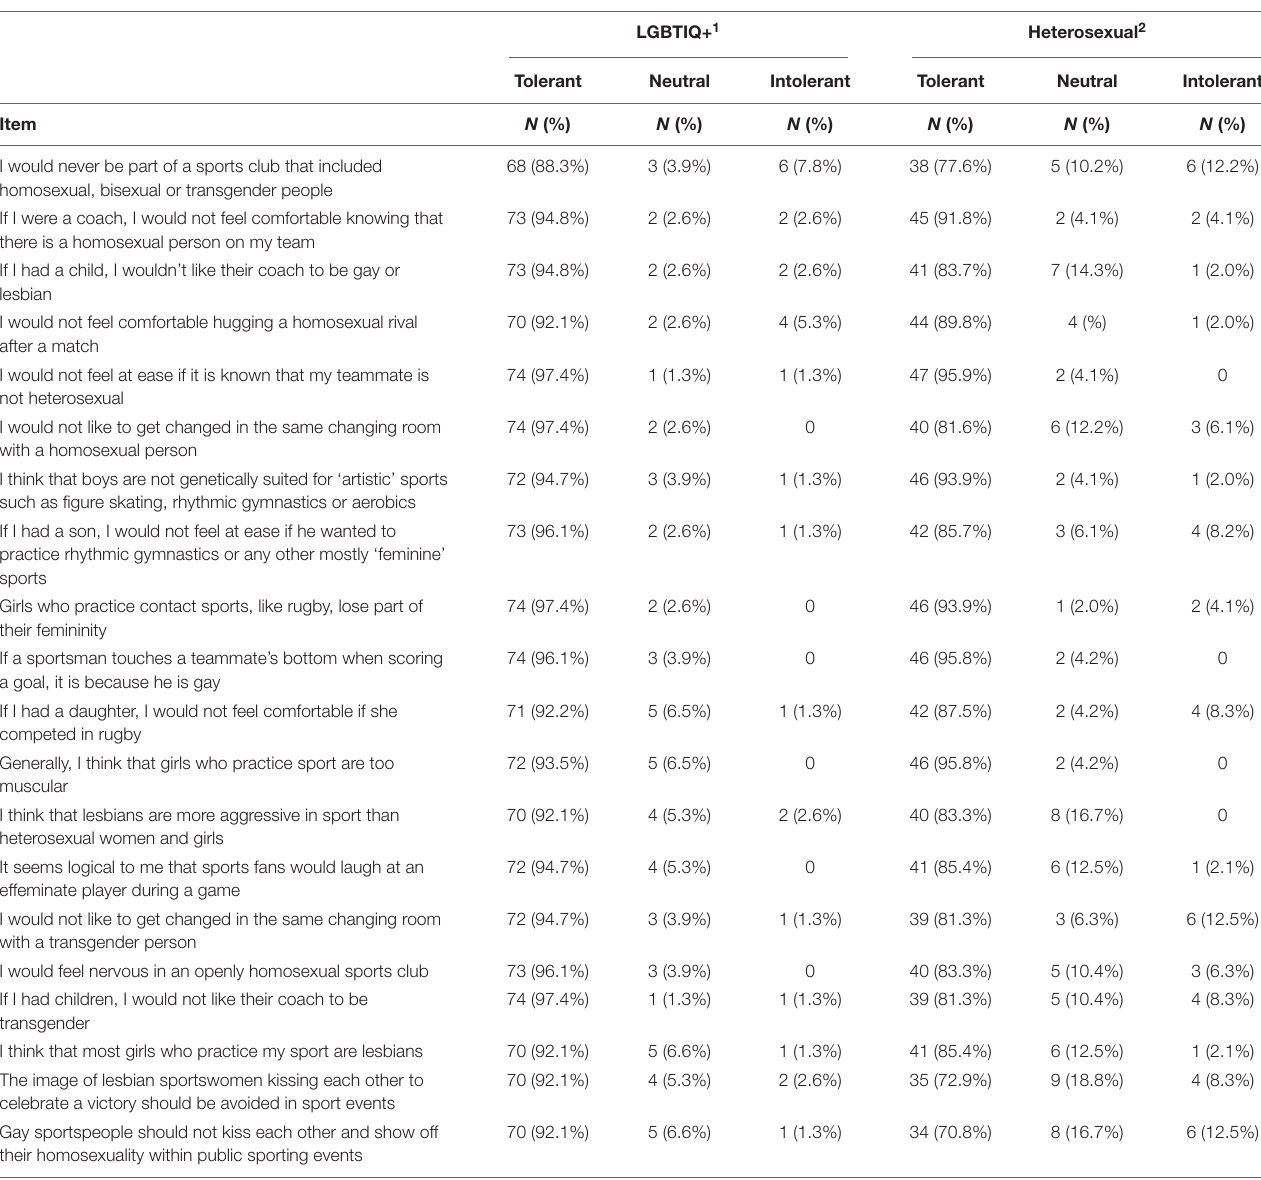
TABLE 3 | Summary of acceptance of LGBTIQ+ people in